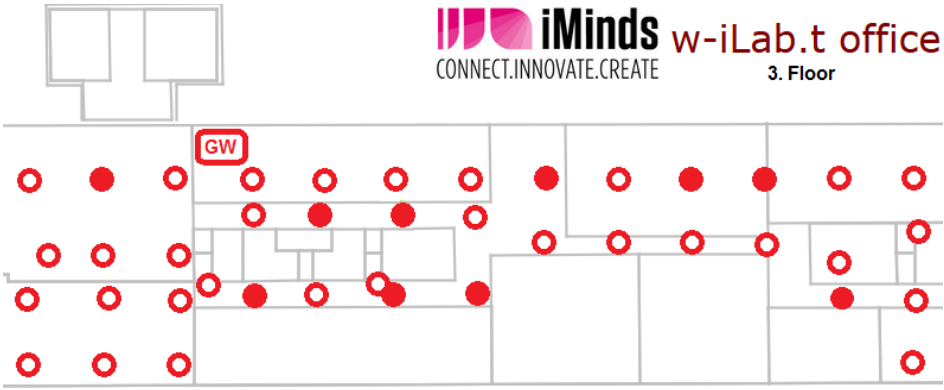
Figure 15. Experimental setup at the w-iLab.t office. The circles represent the location of the nodes on the third floor of the office building. The filled circles represent the nodes used in the experiment. The other nodes were